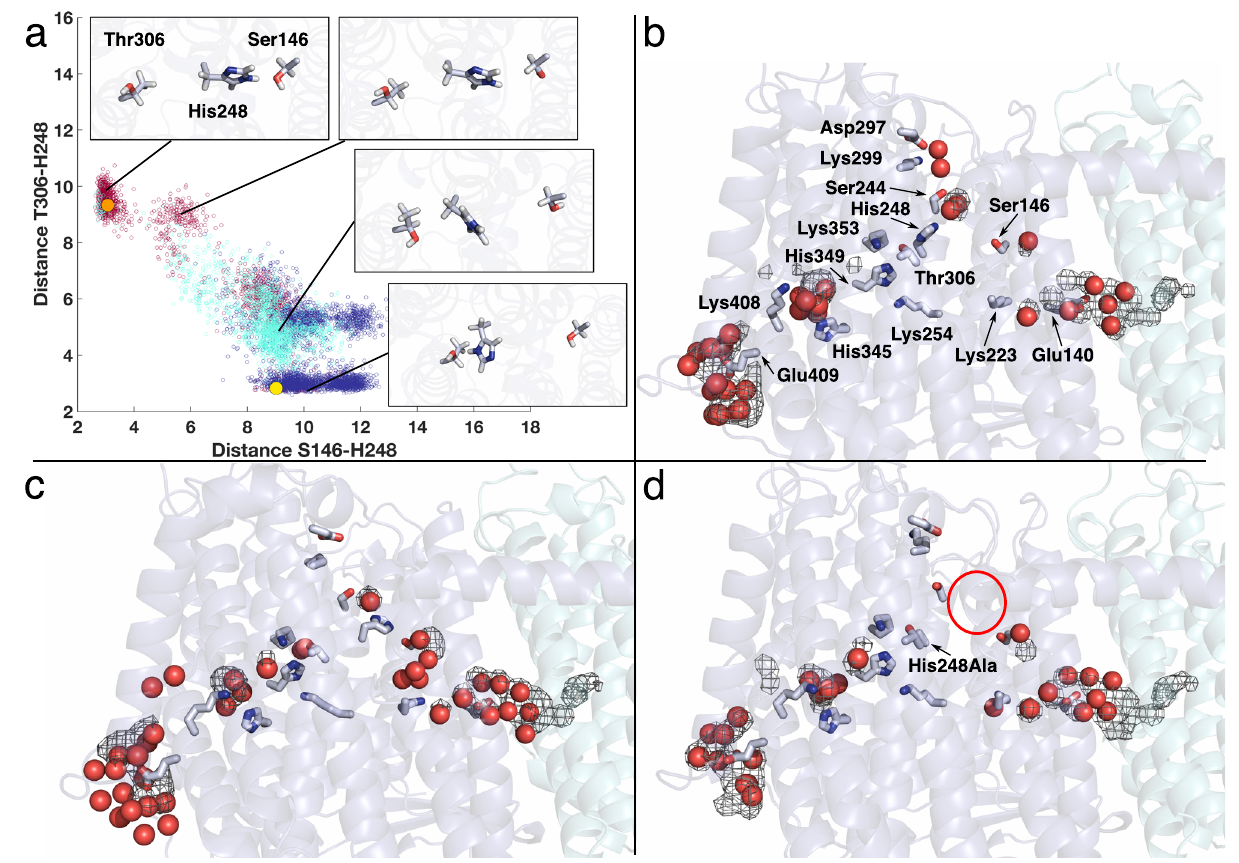
Fig. 5 | Protonation-dependent conformational dynamics of His248 MrpA . a Scatter plot displaying distances between NE2 atom of His248 MrpA and OG atoms of Ser146/Thr306 MrpA from PBE (neutral His248 with ε nitrogen protonated - bur- gundy), PBP (doubly protonated His248 - cyan), and PB1 (neutral His248 with δ nitrogen protonated - blue) simulations. Solid yellow and orange spheres indicate the structural distances seen in alternative A and B conformations (compare Fig. 2 andSupplementaryMovie1),respectively.Representativesnapshotsfromdifferent regionsof thescatterplotdemonstratetheconformationalvarietyobserved